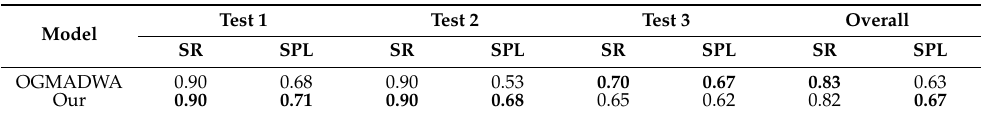
Table 2. Performance comparison results of the proposed algorithm with OGMADWA on the real- world